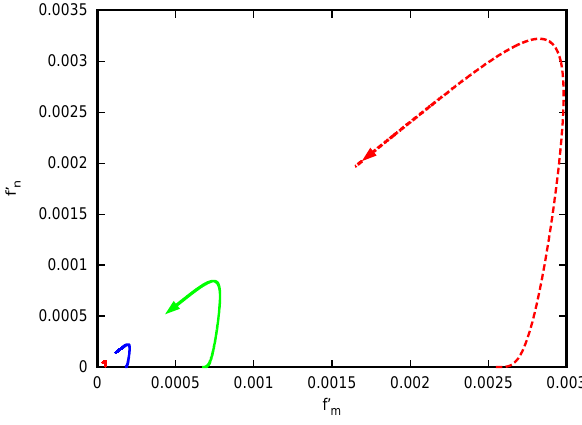
Fig. 4. f 0 n vs. f 0 m for various initial geometric mean masses from 1 to 1000 ng (dashed red, solid green, blue, red). Note that the inverse values of the axis correspond to the timescales for the change of the corresponding integrals I k ( t ) in seconds. Arrows indicate the direction of time.